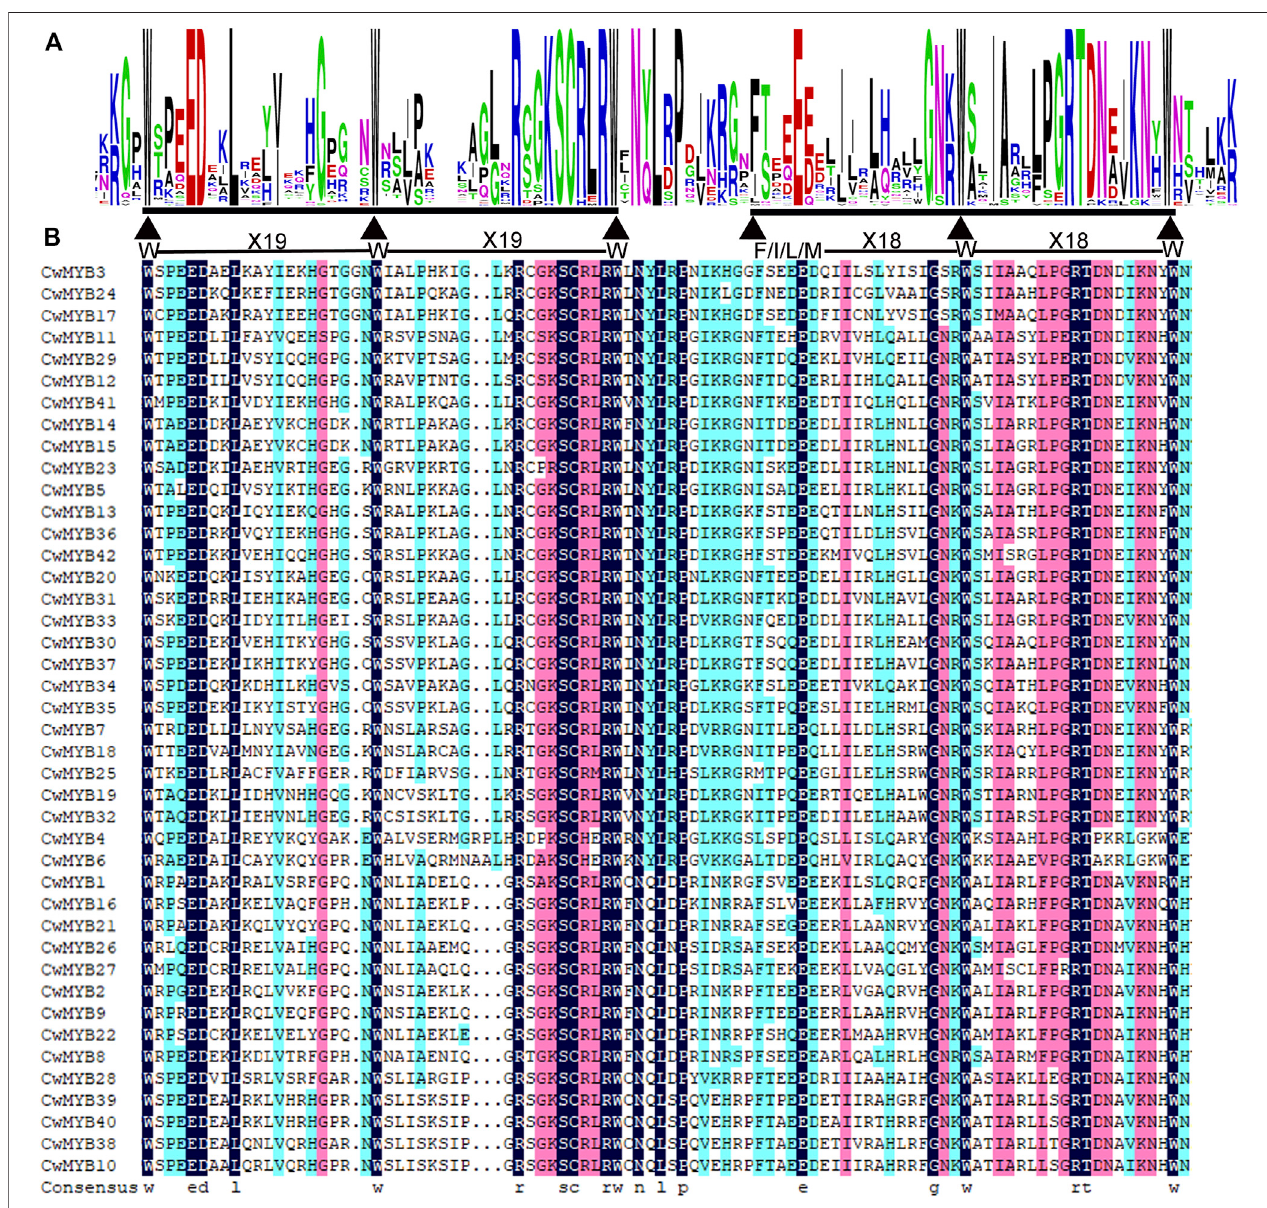
FIGURE 1 | Conserved domains in R2R3 type CwMYB1-42 from C. wenyujin . (A) The sequence logos of conserved domains R2 and R3 repeat. Letter height indicates the sequence ’ s content and conservation at the corresponding position. Triangles in the MYB domain represent conserved amino acid residues or motifs. Weblogo 3 online software was used to create the image. (B) The conserved domain R2 (-W-X 19 -W-X 19 -W-) and R3 (-F/I/L/M-X 18 -W-X 18 -W-) repeats. The amino acid residues with a black background indicate 100% identity in the CwMYB1-42 protein sequences.